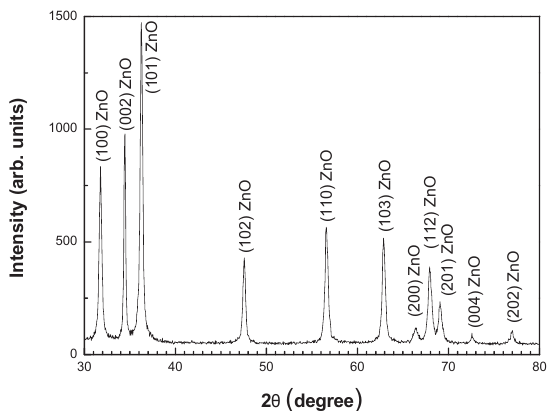
Fig. 1 XRD data of the nanocrystalline ZnO flakes syn- thesized via a solution process using zinc acetate and diethylamine under refluxing at 85 ℃ for 4 h.